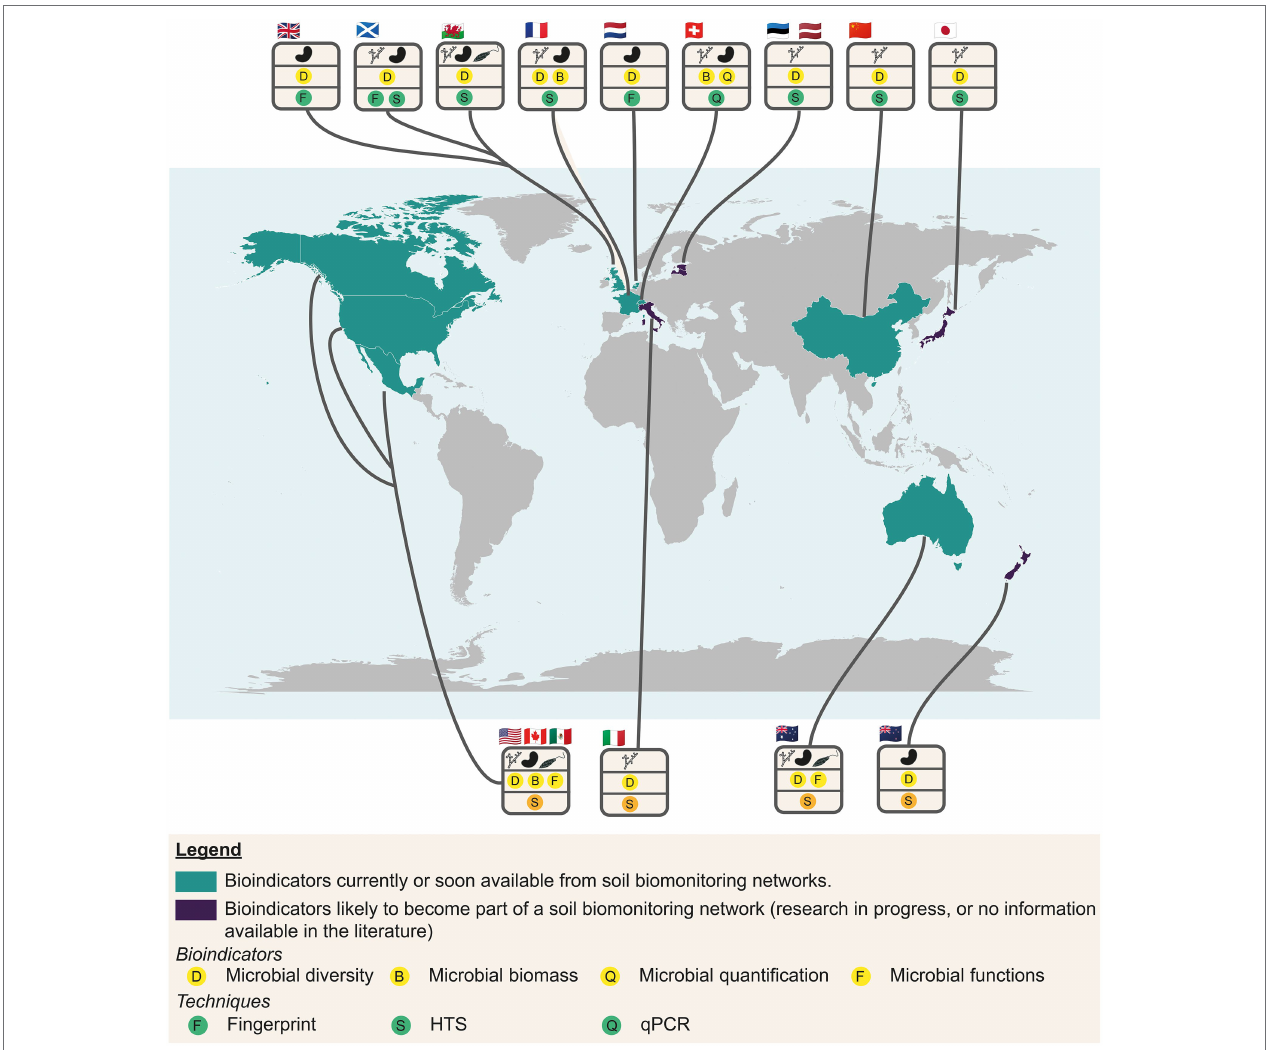
FIGURE 7 | World map showing the main surveys used to monitor the soil quality thanks to repositories based on modern and operational microbial indicators or in progress (turquoise) and studies in the research phase (purple). Microbial indicators are symbolized by circles with a yellow background, and methods by circles with a green